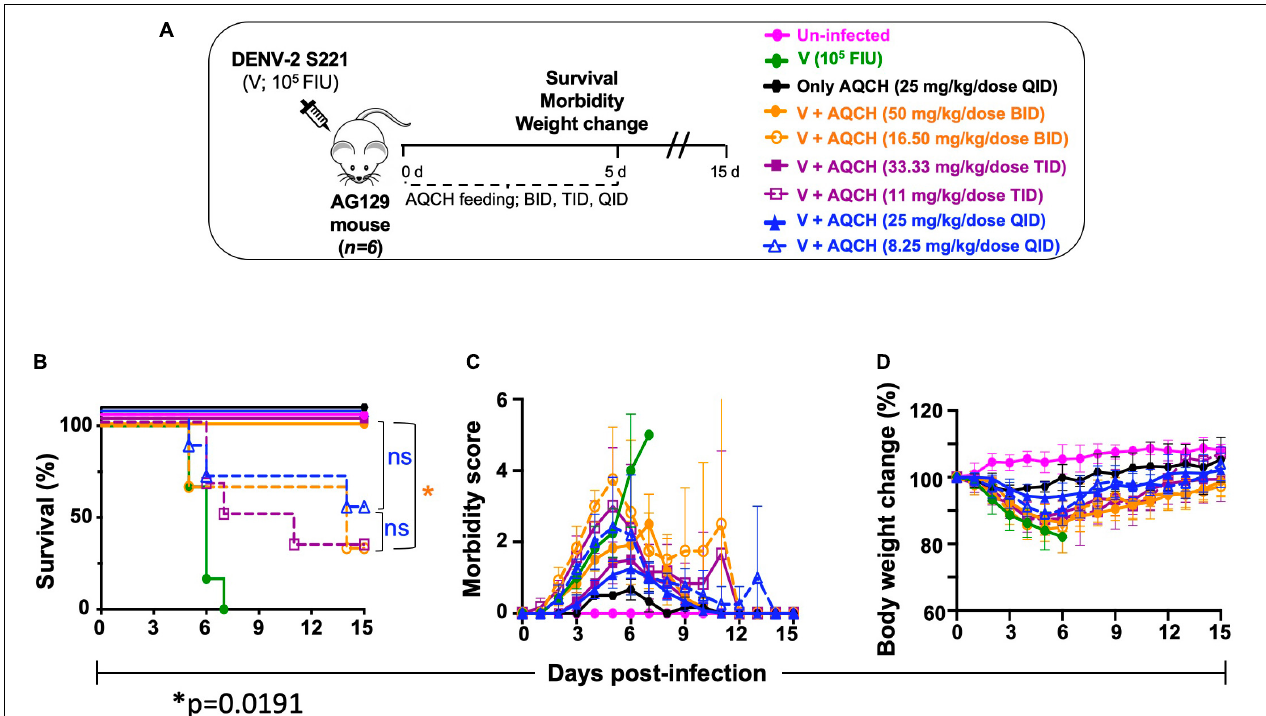
FIGURE 4 | Effect of AQCH dose and dosing regimen against lethal primary DENV infection. (A) Schematic representation of study design. Groups of AG129 mice ( n = 6) inoculated with lethal dose of mouse-adapted DENV-2 S221 virus (10 5 FIU/Mouse); thereafter, mice were orally gavage with two doses of AQCH, viz ., 100 mg/kg/day (solid curves) and 33 mg/kg/day (dashed curves) in three different dosing regimen, i.e., twice a day (BID; orange curves), thrice a day (TID; purple curves), and four times a day (QID; blue curves) for 5 days and mice were monitored for another 10 days, for their survival (B) , morbidity (C) , and body weight change (D) . Uninfected (neither infected with virus nor fed with AQCH; represented by magenta), virus-infected, V (infected with virus but not fed with AQCH; represented by green curves), and Only AQCH (not infected with virus but fed with AQCH at 25 mg/kg QID; black curves) groups of AG129 mice served as experimental controls. Not significant (ns) and single star (*) of right side of survival graph denotes their statistical differences between same dosing schedule of different